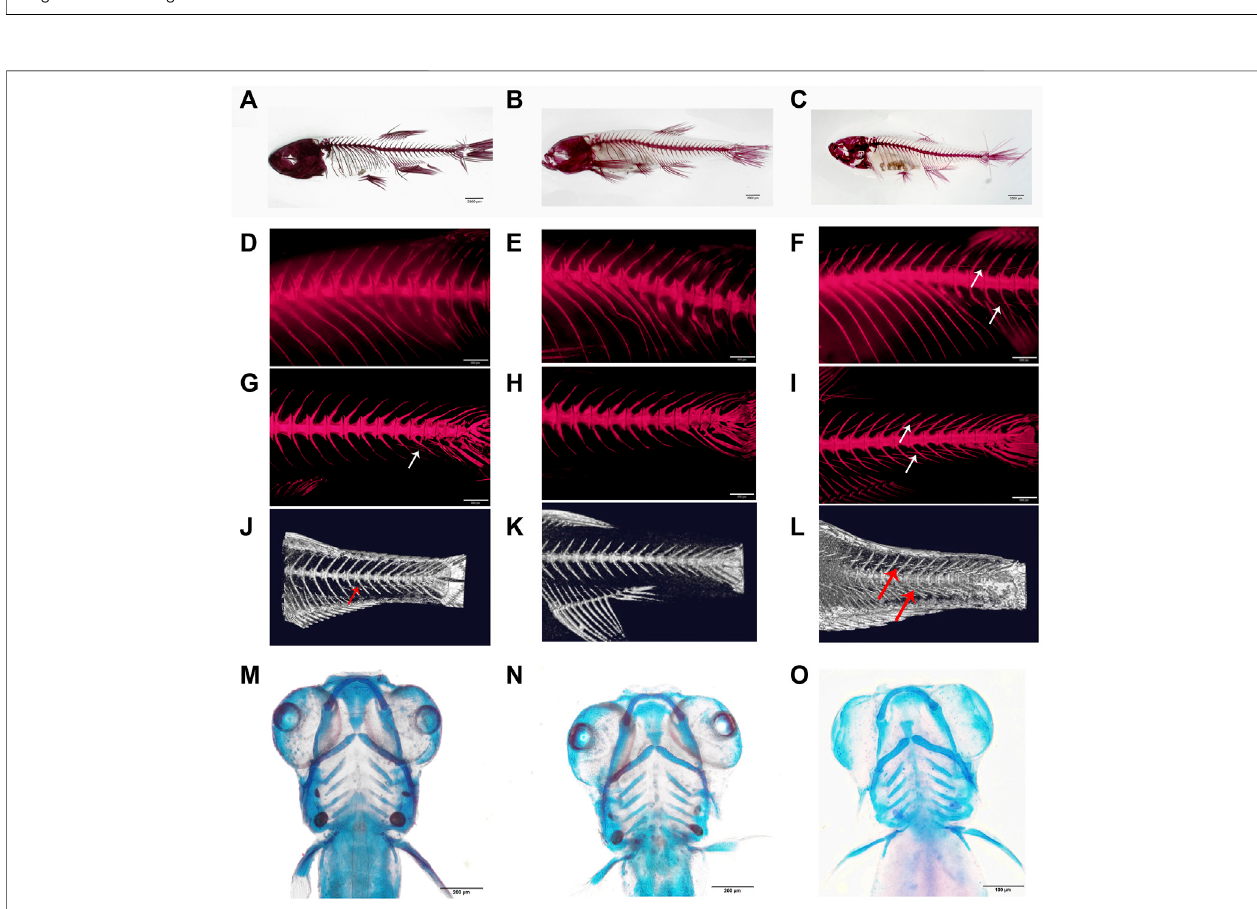
FIGURE2 | Phenotypes of bmp6 knockout mutants. (A – C) Bone staining withAlizarin red ofM mutant, that is, IBpartially de fi cient mutant (A), Amutant, thatis, IB depletionmutant(B)andwild-typezebra fi sh(C)at60dph. (D – F) BonestainingofthedorsalpartofMmutant,Amutant,andwild-typezebra fi sh,respectively. (G – I) Bone staining of the caudal part of M mutant, A mutant, and wild-type zebra fi sh, respectively. (J – L) Micro-CT images of the caudal skeleton of M mutant, A mutant, and wild- type zebra fi sh, respectively; the IBs were only found in the ventral part of the M mutant (A,D,G,J), whereas the IBs were lacking in the A mutant (B,E,H,K). (M – O) Bone staining of the skull of wild M mutant (M), A mutant (N), and wild-type zebra fi sh (O) at 6 dph.